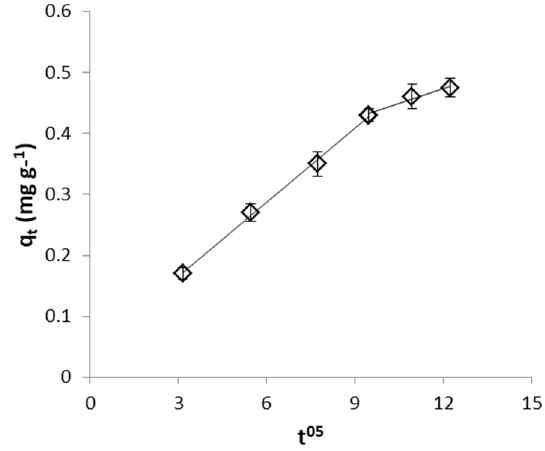
Figure 14. Weber and Morris plot for Cr VI removal by WSP-Fe 0 .